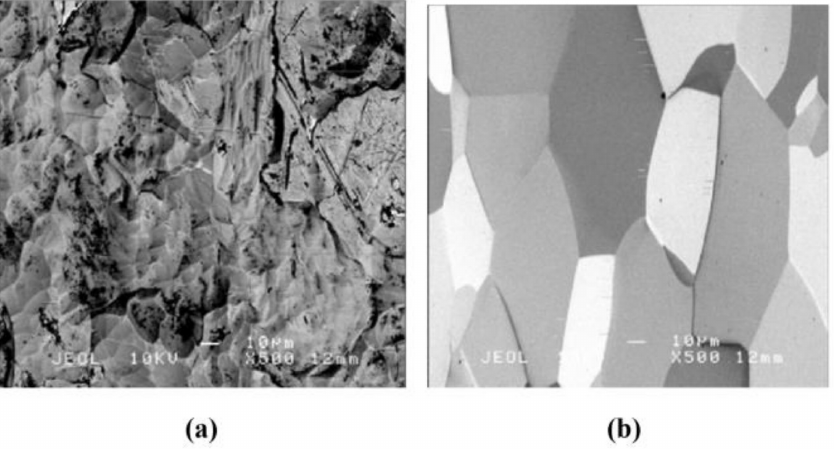
Figure 17. SEM views of the initial ( a ) and IL-polished ( b ) niobium sheet (reprinted with permission from ref. [65]; Copyright 2010 The Electrochemical Society).